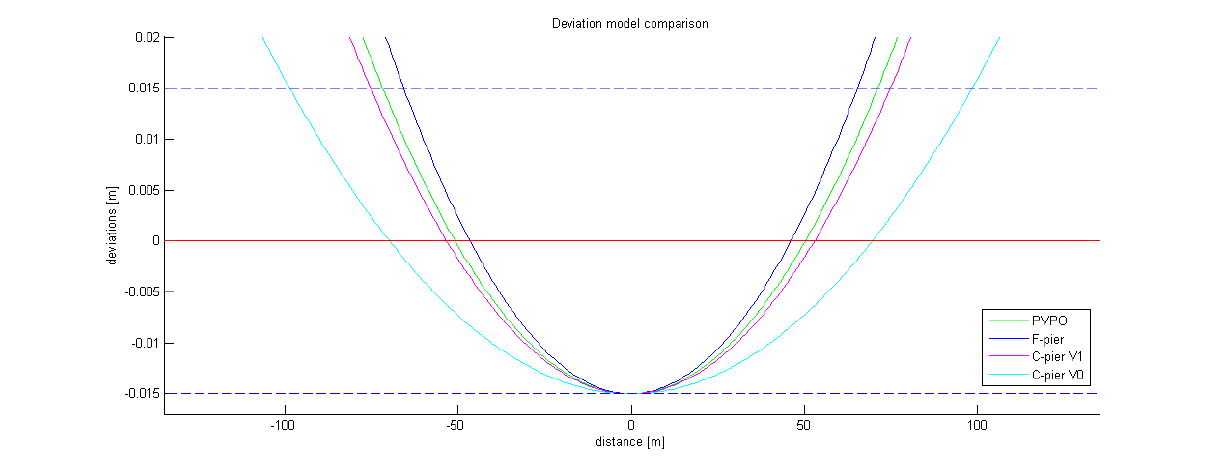
Figure 4: Error prediction model: All deviation models are realigned to fit the maximum allowed error in LOA30. The stripped blue lines indicates LOA30 boundaries. The quadratic curves depict the bending curves for each